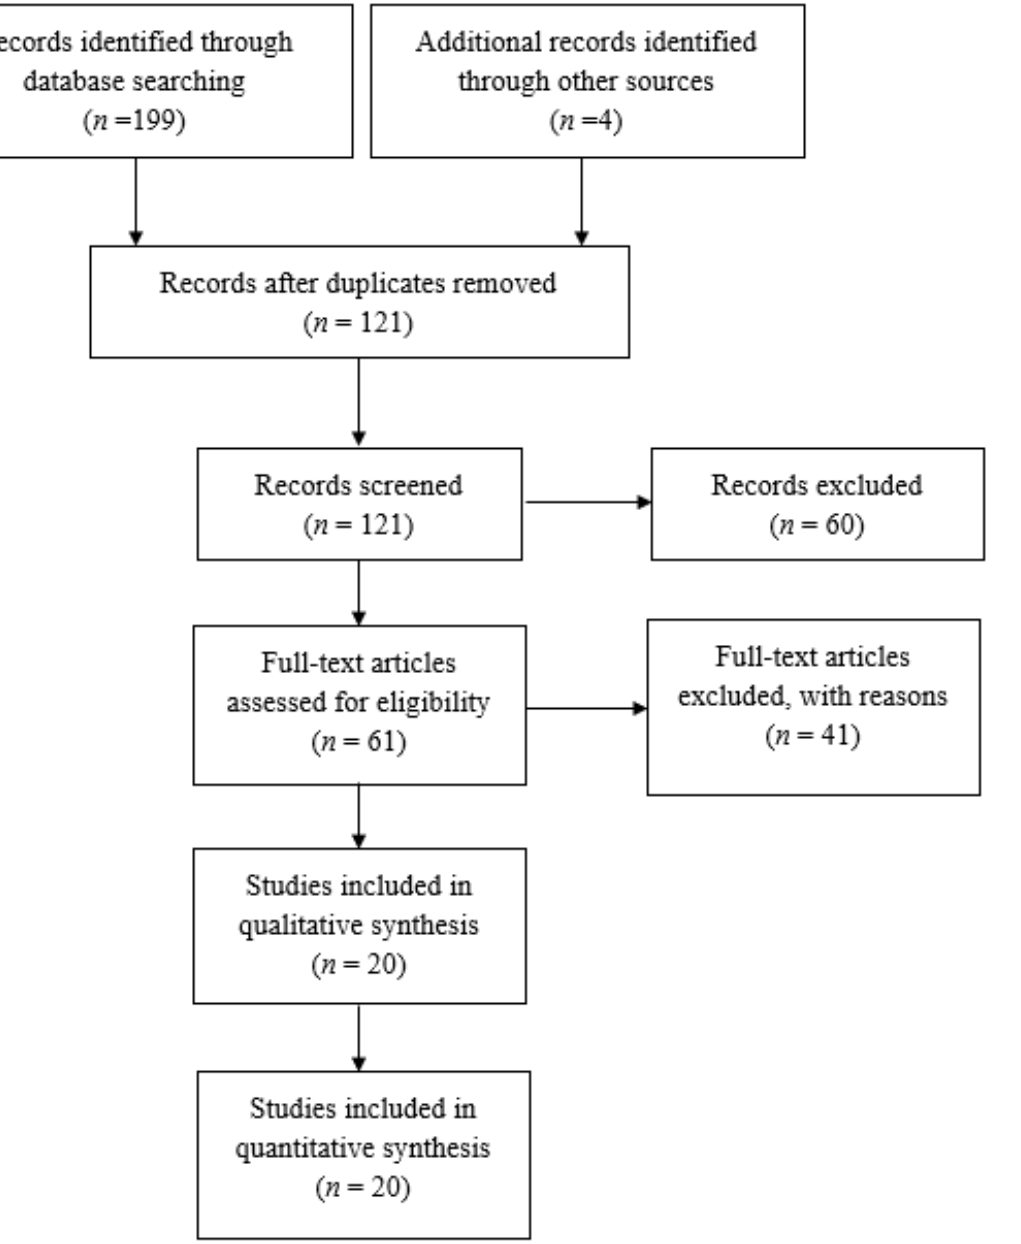
Figure 1. Flowchart depicting the selection process for inclusion of studies in the article. The publication date of the studies that were included in this systematic review and meta-analysis ranged from 2012 to 2021 with four studies published in 2021 [20,24–26]. The shortest study period among the studies was eleven months [35], while the longest one was sixty months [29]. The total number of patients across the 20 studies included in this systematic review and meta-analysis was 2920. Out of the above-mentioned number of patients, 1601 patients in total received carbon nanoparticle suspension during their operation, while the rest 1319 were allocated to control groups. The characteristics of each individual study are shown in Table